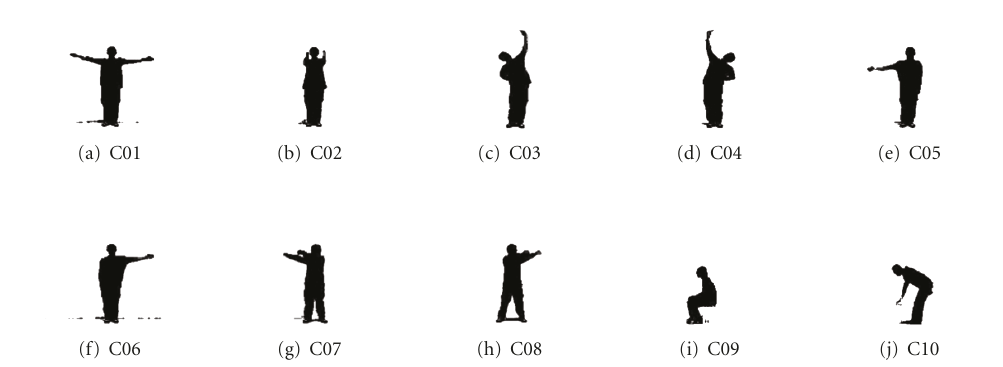
Figure 14: The selected frames from ten categories of the new public database.